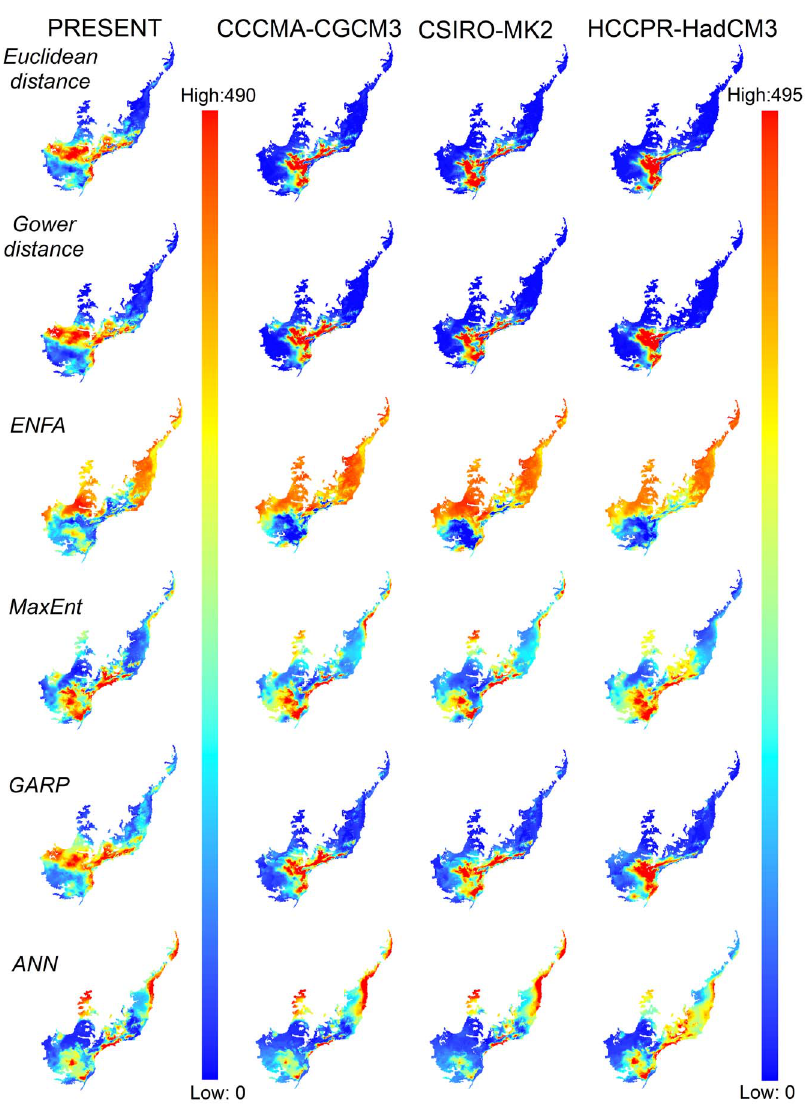
Figure 2. Species richness patterns for tiger moths in the Atlantic Forest Biodiversity Hotspot, Brazil. Tiger moth species richness patterns in the Atlantic Forest, Brazil (present and future, 2080, climate models CCCMA-CGCM3, CSIRO-MK2, and HCCPR-HadCM3) forecasted by ecological niche models generated by different distance modeling methods (Euclidian and Gower distances, Ecological Niche Factor Analysis, ENFA) and machine learning methods (Maximum Entropy, MaxEnt; Genetic algorithm for Rule set Production, GARP; Artificial Neural Networks, ANN).